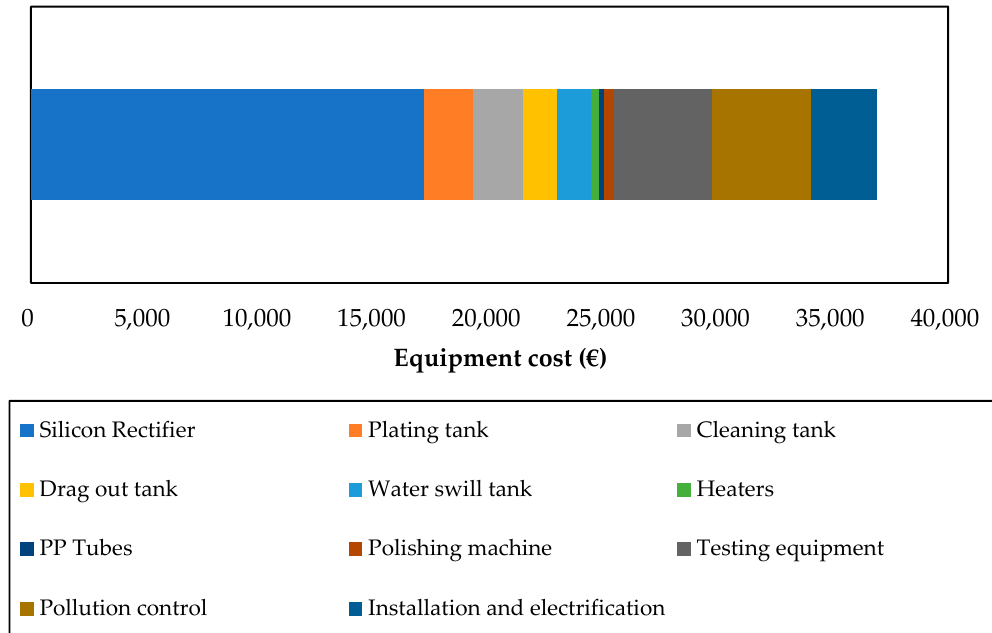
Figure 9. Cost breakdown of electrodeposition equipment (€).